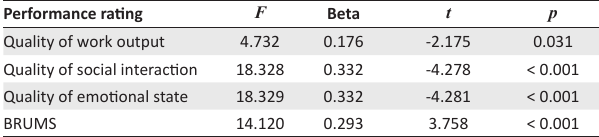
BRUMS, Brunel Mood Scale.